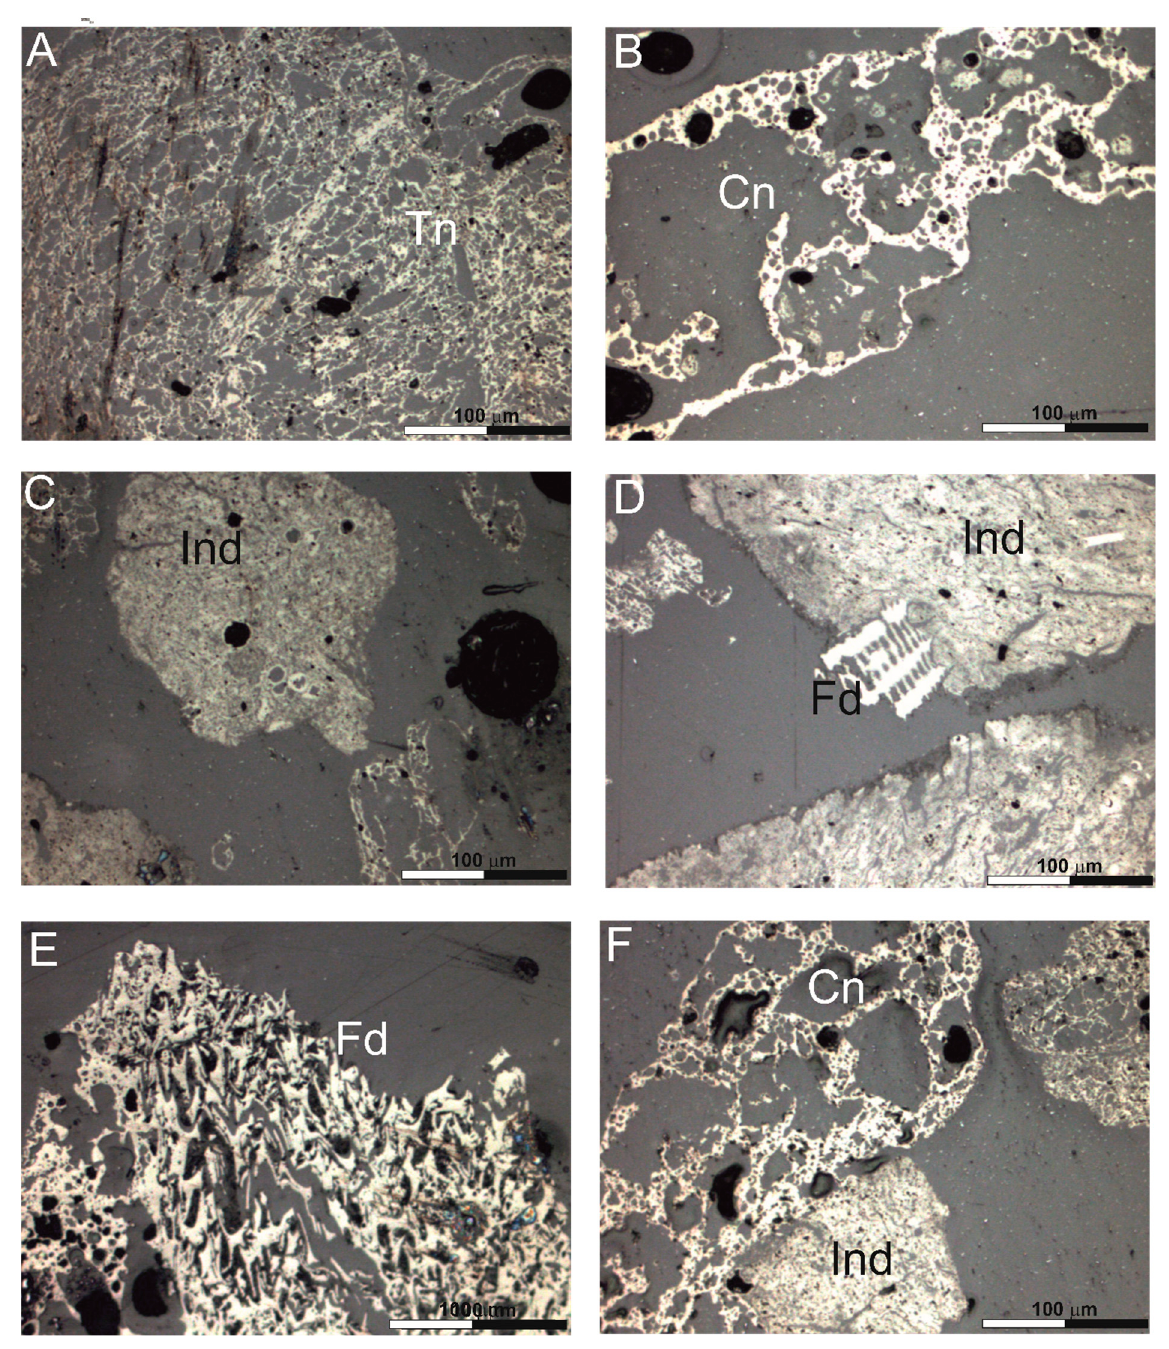
Figure 1. Char morphotypes: ( A )—tenuinetwork, ( B )—crassinetwork, ( C )—inertoid, ( D )—inertoid and fusinoid, ( E )—fusinoid, ( F )—crassinetwork and inertoid. Explanations: Tn—tenuinetwork, Cn—crassinetwork, Ind—inertoid, Fd—fusinoid.